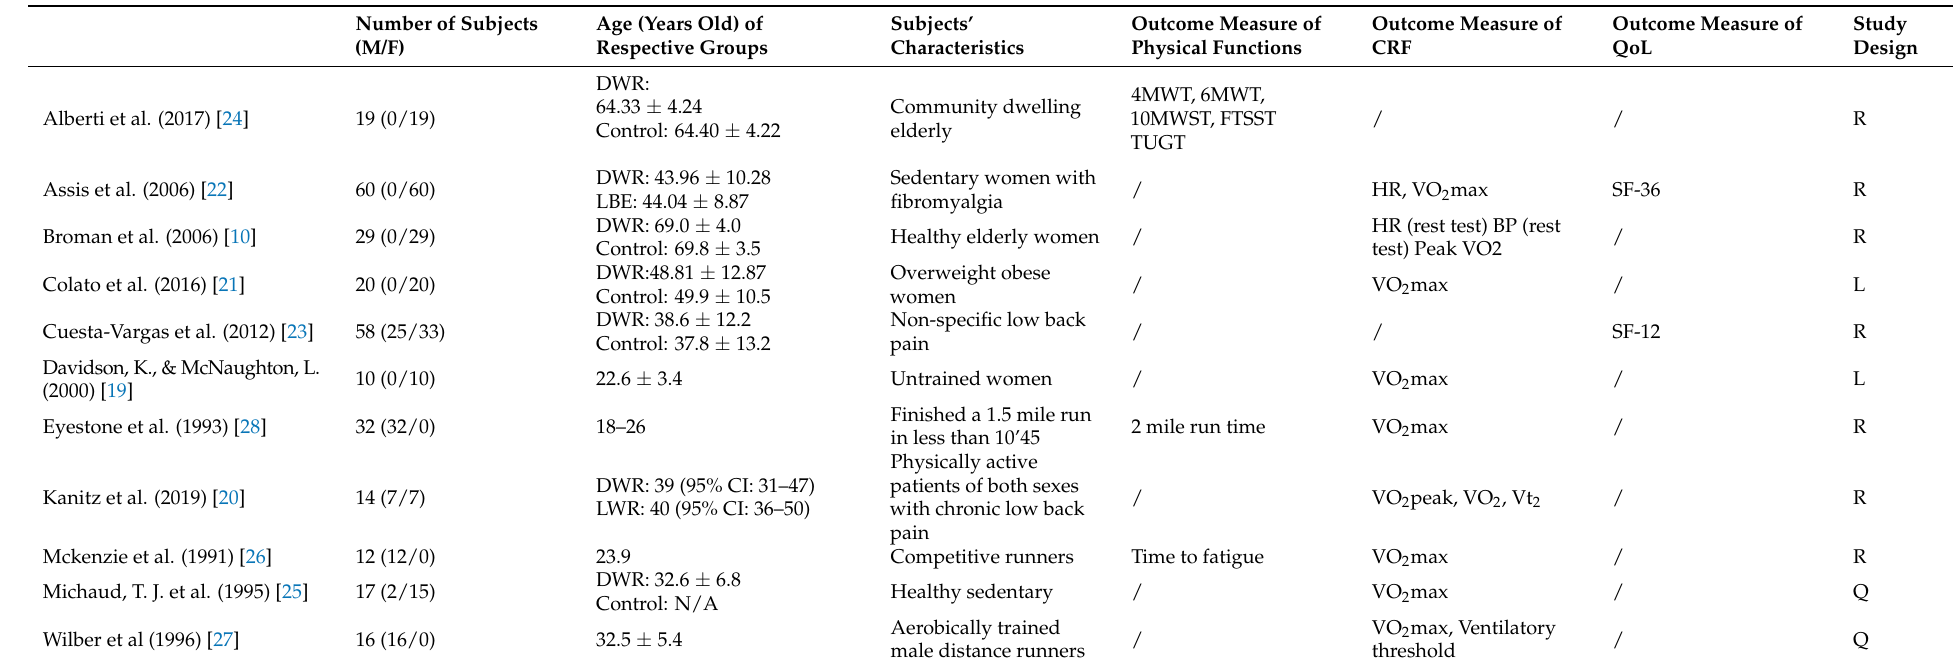
Table 2. Study design of included